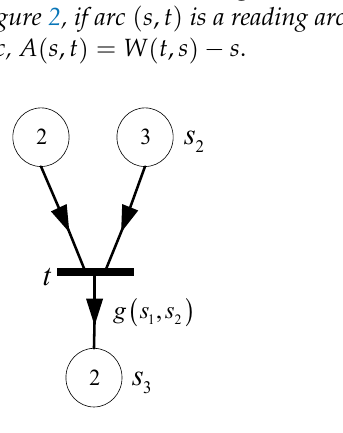
Figure 3. Inhibit arc and permit arc.